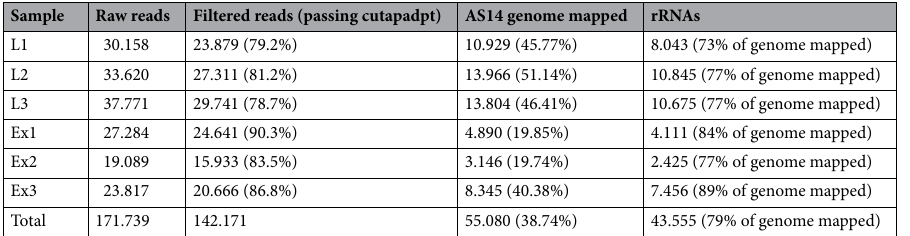
Table1. RNA-seq results from the sequencing of the small-RNA fraction isolated from infective third-stage larvae of Anisakis pegreffii and its released extracellular vesicles. Data on raw reads, reads passed cutadapt, reads mapping to the Anisakis simplex genome and to rRNAs are reported. Numbers indicate million reads.